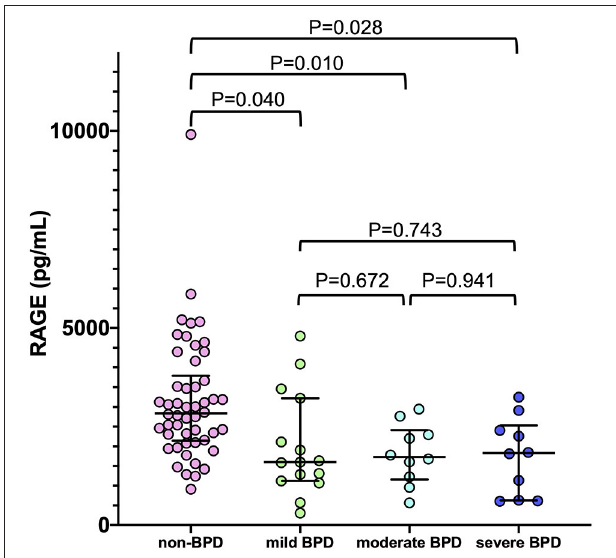
FIGURE 4 | The correlation between serum sRAGE levels at birth and severity of BPD (non-BPD: n = 50, mild BPD: n = 15, moderate BPD: n = 9, severe BPD: n = 10). Horizontal bars denote the median and interquartile values in each group of infants. The P -values were calculated using the Mann-Whitney U -test and Bonferroni correction. BPD, bronchopulmonary dysplasia.